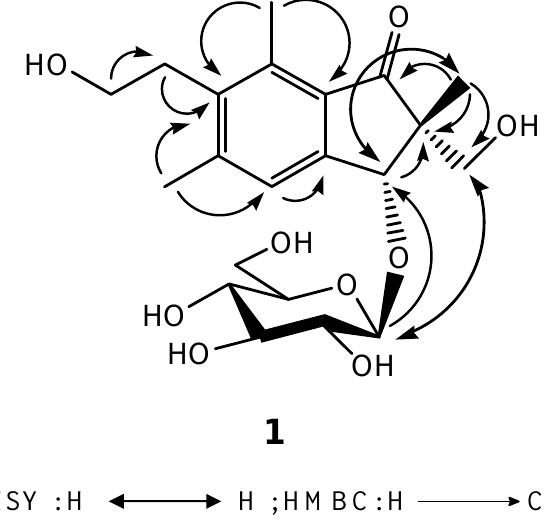
Figure 2. NOESY and HMBC correlations of compound